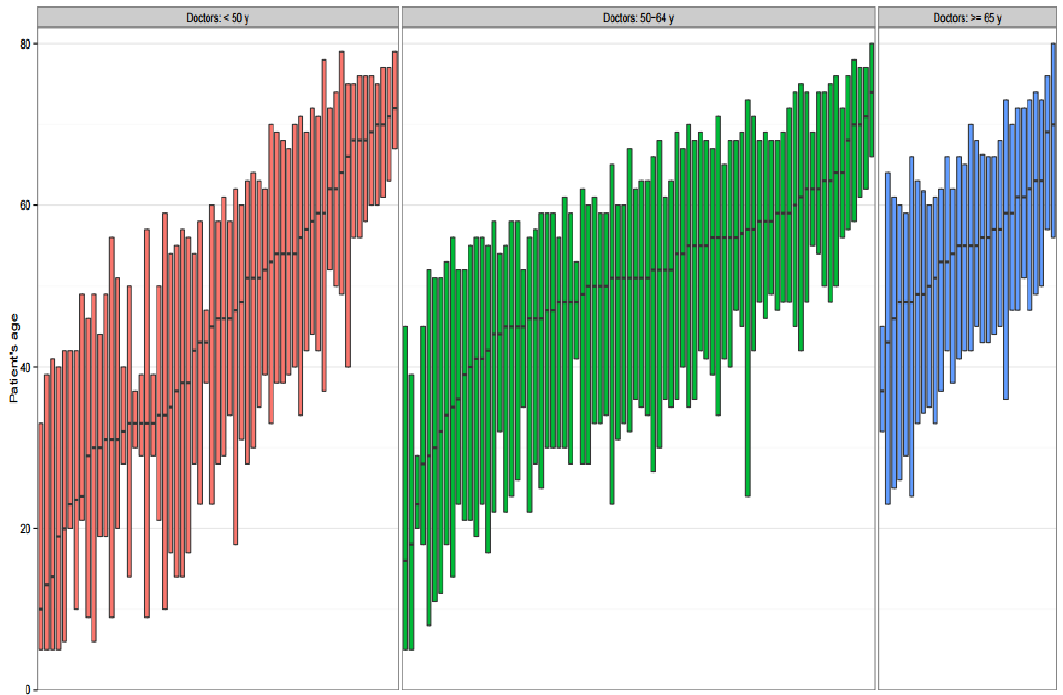
Figure 1. Patients’ age distribution for visits to each physician (sorted according to median age for each physician age group). Each red, green, and blue boxplot represented the physician age groups <50 years old, 50–64 years old, and ≥65 years old, respectively.